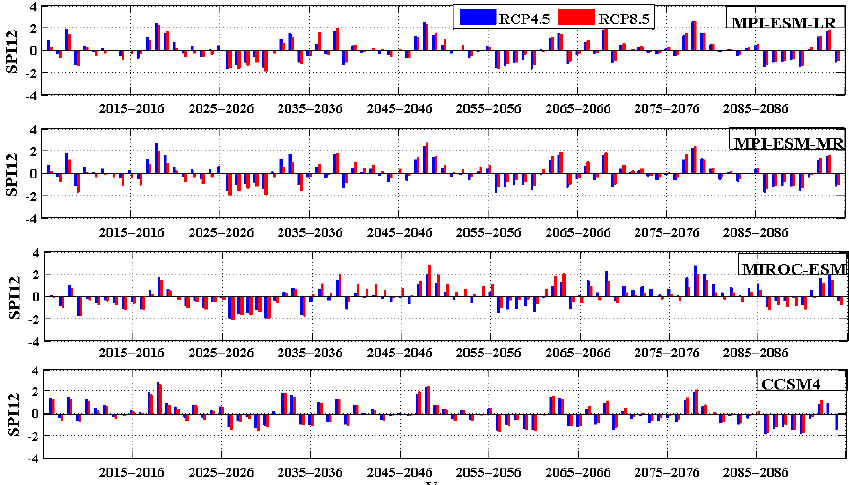
Figure 15. As in Fig. 14 but when the CF approach is